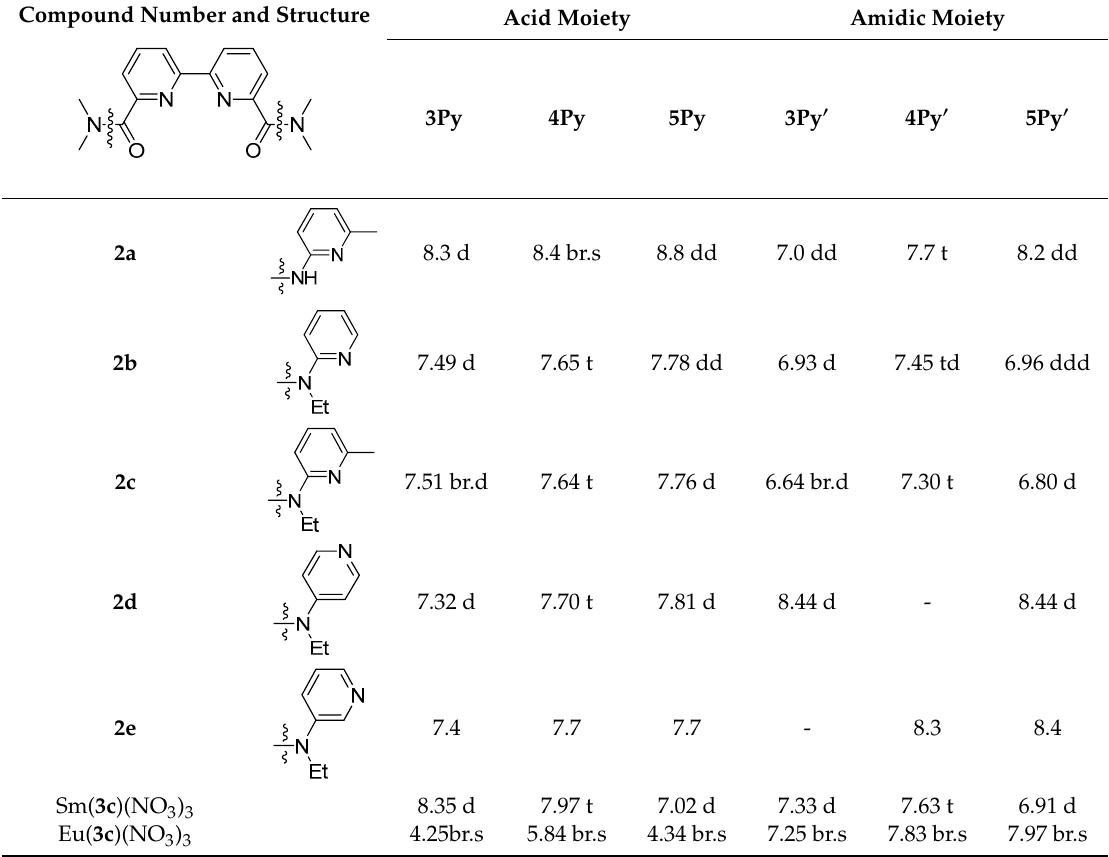
Table 1. Chemical shifts (in ppm) of aromatic protons for 2c ligand and their complexes. Compound Number and Structure